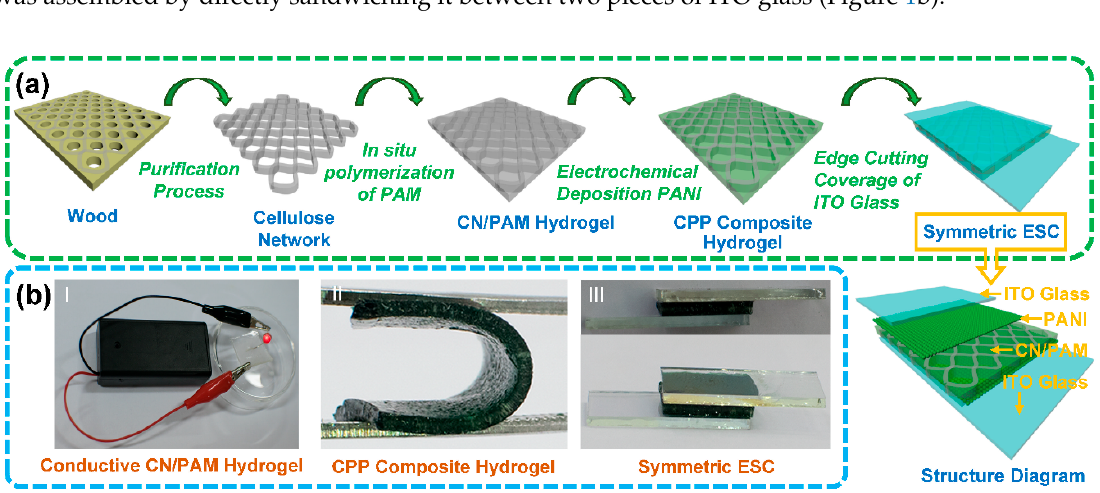
Figure 1. Construction procedures and digital photographs of the cellulose network / polyacrylamide / polyaniline (CPP) composite hydrogel and the corresponding electrochromic supercapacitors (ESCs): ( a ) schematic diagram of the preparation process of the symmetric ESC and its structure diagram, ( b ) digital photographs that show the conductivity of cellular network (CN) / polyacrylamide (PAM) conductive hydrogel (I), the flexibility of the CPP composite hydrogel (II), and the symmetric ESC (III).